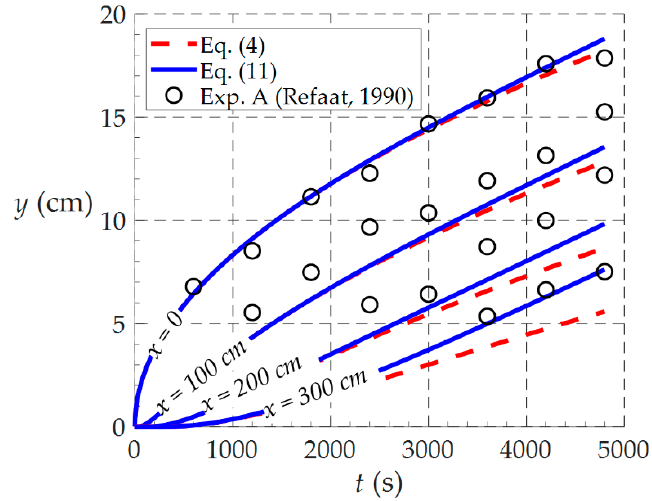
Figure 10. Comparison between theoretical and experimental data.